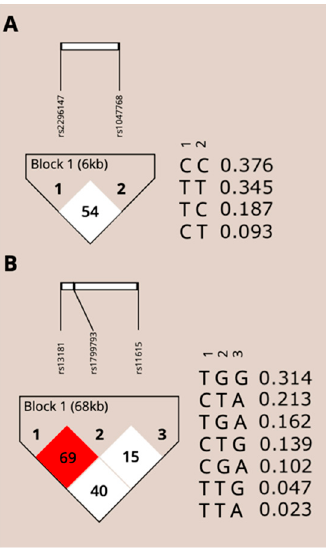
Figure 3. ( A ) Linkage disequilibrium (LD) block and haplotype frequencies for rs2296147 and rs1047768 in ERCC5 gene. ( B ) LD block and haplotype frequencies for r1318, rs799793 and rs11615 in ERCC1 and ERCC2 genes.